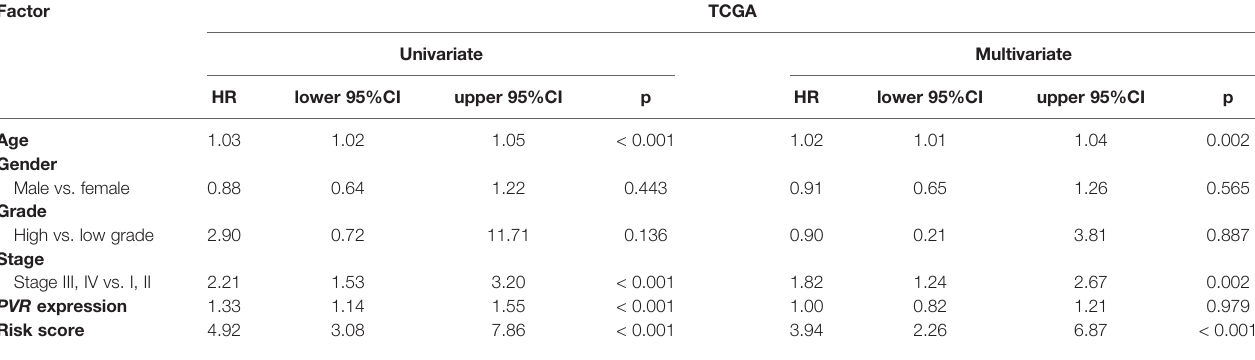
TABLE 3 | Univariate and multivariate Cox analyses in TCGA BLCA cohort. Factor TCGA Univariate